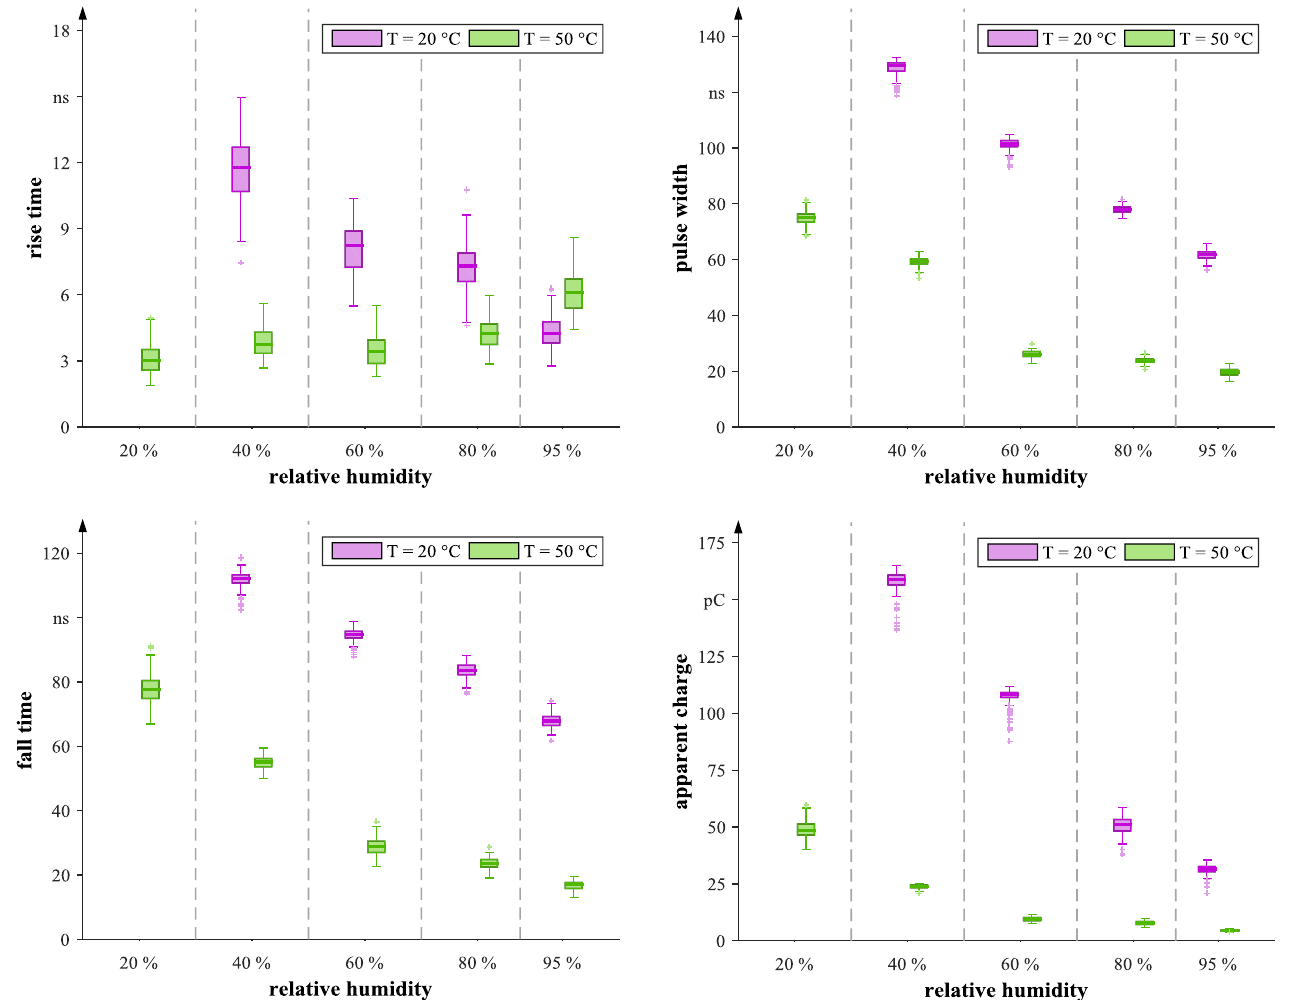
Fig. 9. Box plots for the pulse shape parameters rise time (top left), pulse width (top right), fall time (bottom left) and the apparent charge (bottom right) of positive corona discharges occuring under a varying relative humidity level for temperature levels of 20 °C and 50